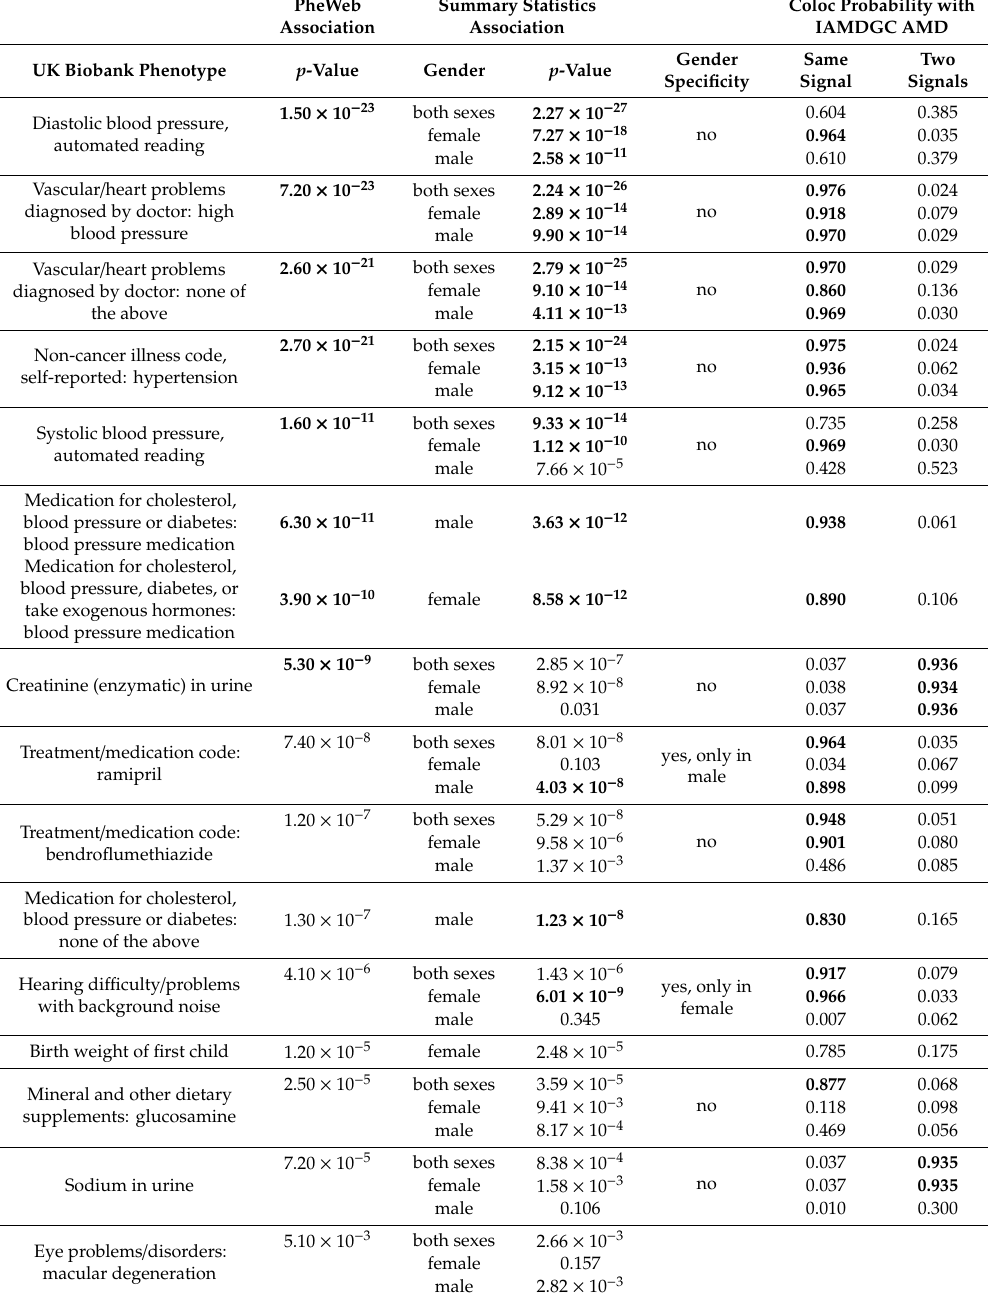
Table 3. Association of rs2168518 in the UK Biobank genome-wide association studies (GWAS) summary statistics. Fifteen phenotypes display a significant association with rs2168518 ( p -value < 1 × 10 − 4 ) in the UK Biobank PheWeb browser [28]. The association of rs2168518 with Macular Degeneration failed to reach the Table 19. Gender specificity (probability > 0.8 in one gender) was defined by comparison of the association signal in males and females in the UK Biobank summary statistic results using colocalization. Further, a colocalization of the respective signal with the late-stage AMD signal in the IAMDGC dataset (both sexes) was calculated. Coloc probabilities for “one signal” indicate that the same genetic signal underlies the association with AMD and the respective phenotype, while probabilities for “two signals” indicate that di ff erent genetic variants are underlying the associations. Genome-wide association p -values ( < 5 × 10 − 8 ) are indicated in bold, as well as coloc probabilities >